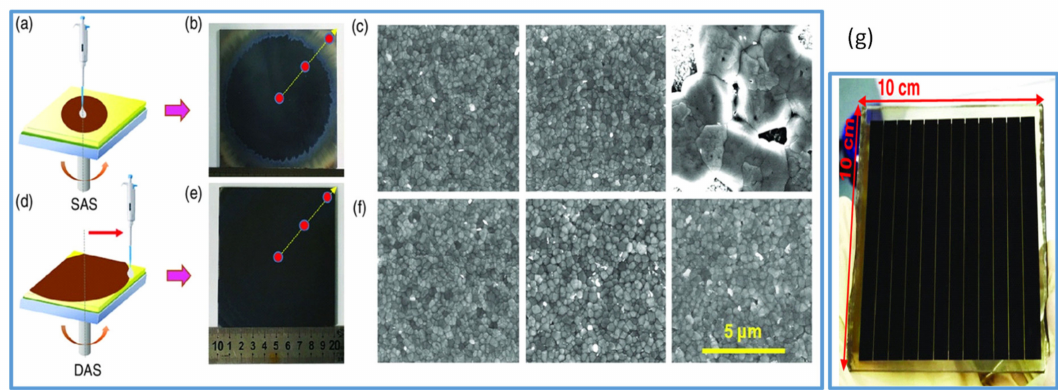
Figure 3. ( a ) Represents the spin coating with static antisolvent (SAS) process. ( b ) The photo of 10 × 10 cm 2 perovskite film by SAS process. ( c ) SEM images of perovskite film from the left to right by SAS process. ( d ) Spin coating with dynamic antisolvent (DAS) process. ( e ) The photo of the 10 × 10 cm 2 large perovskite film by DAS process. ( f ) SEM images of large 10 × 10 cm 2 perovskite films fabricated by DAS process. ( g ) The photo of the solar module by DAS process. Reproduced with permission from ref. [21], Copyright 2019, Solar RRL